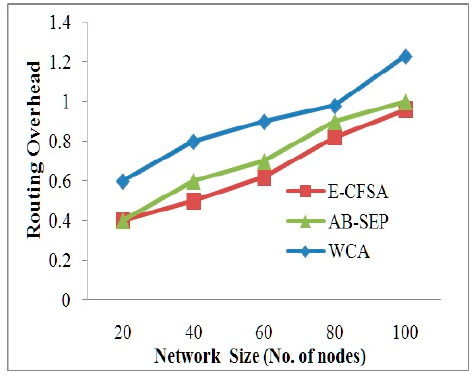
Figure 14. Graph Routing overhead Vs. Network size.